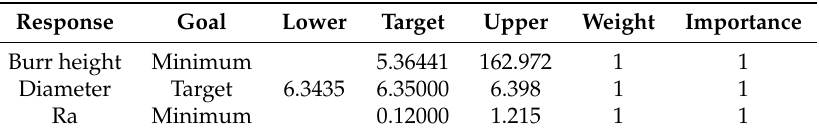
Table 13. Parameter optimization.